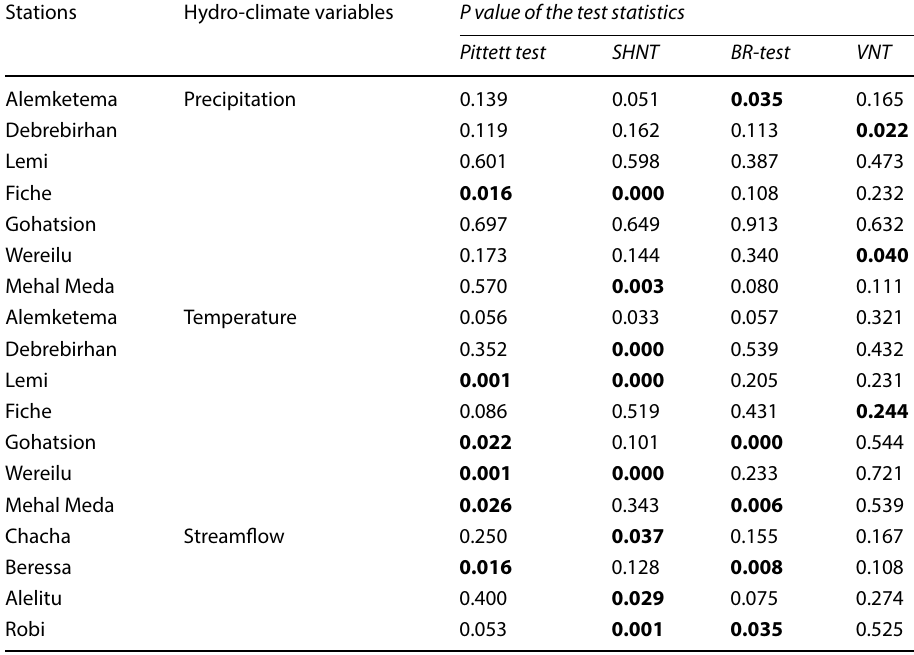
Table 2 Homogeneity test statistics results of hydro- climate